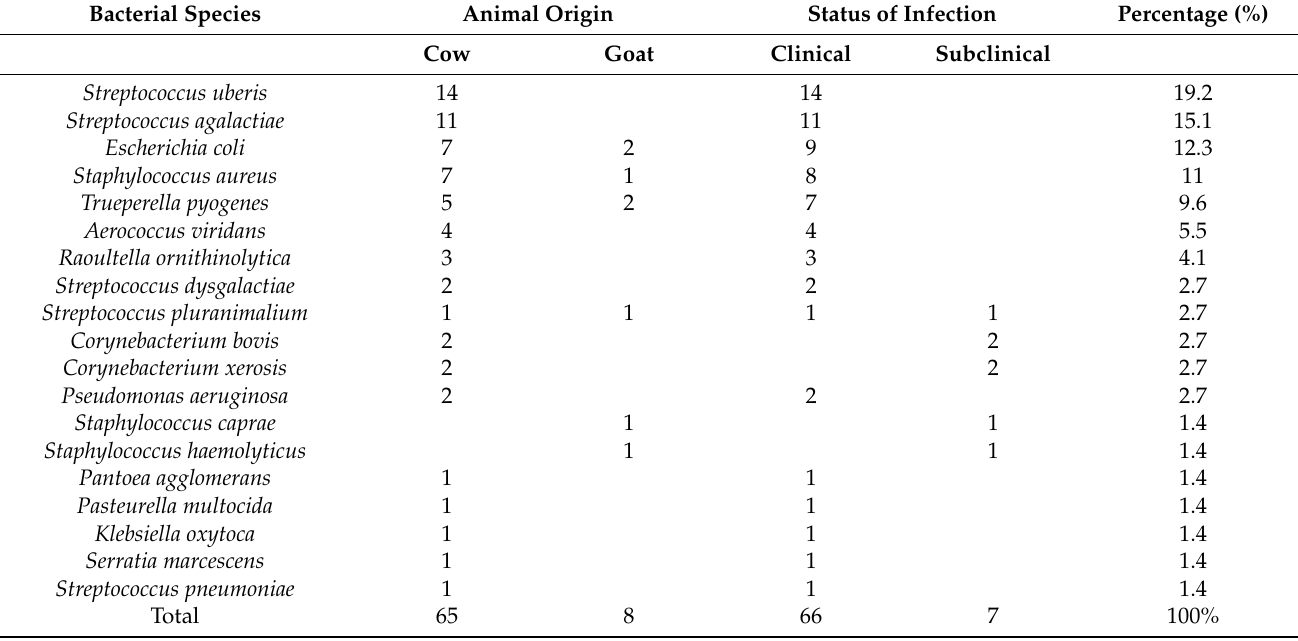
Table 1. Bacterial isolates from clinical and subclinical bovine and caprine mastitis